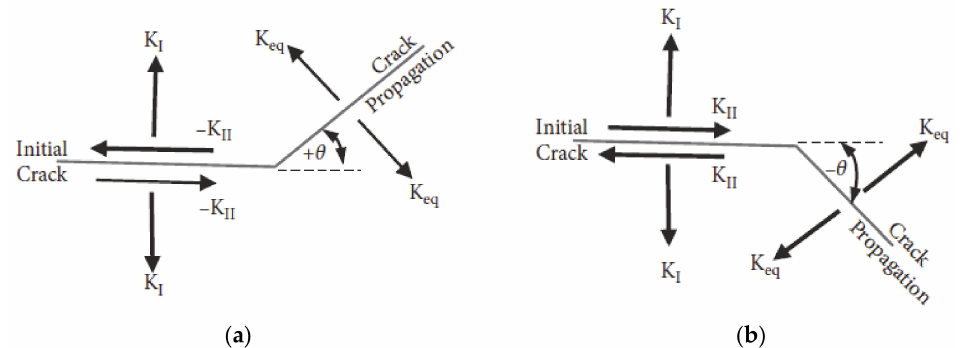
Figure 1. Prospects of the angle of crack propagation ( a ) K II › 0 and ( b ) K II ‹